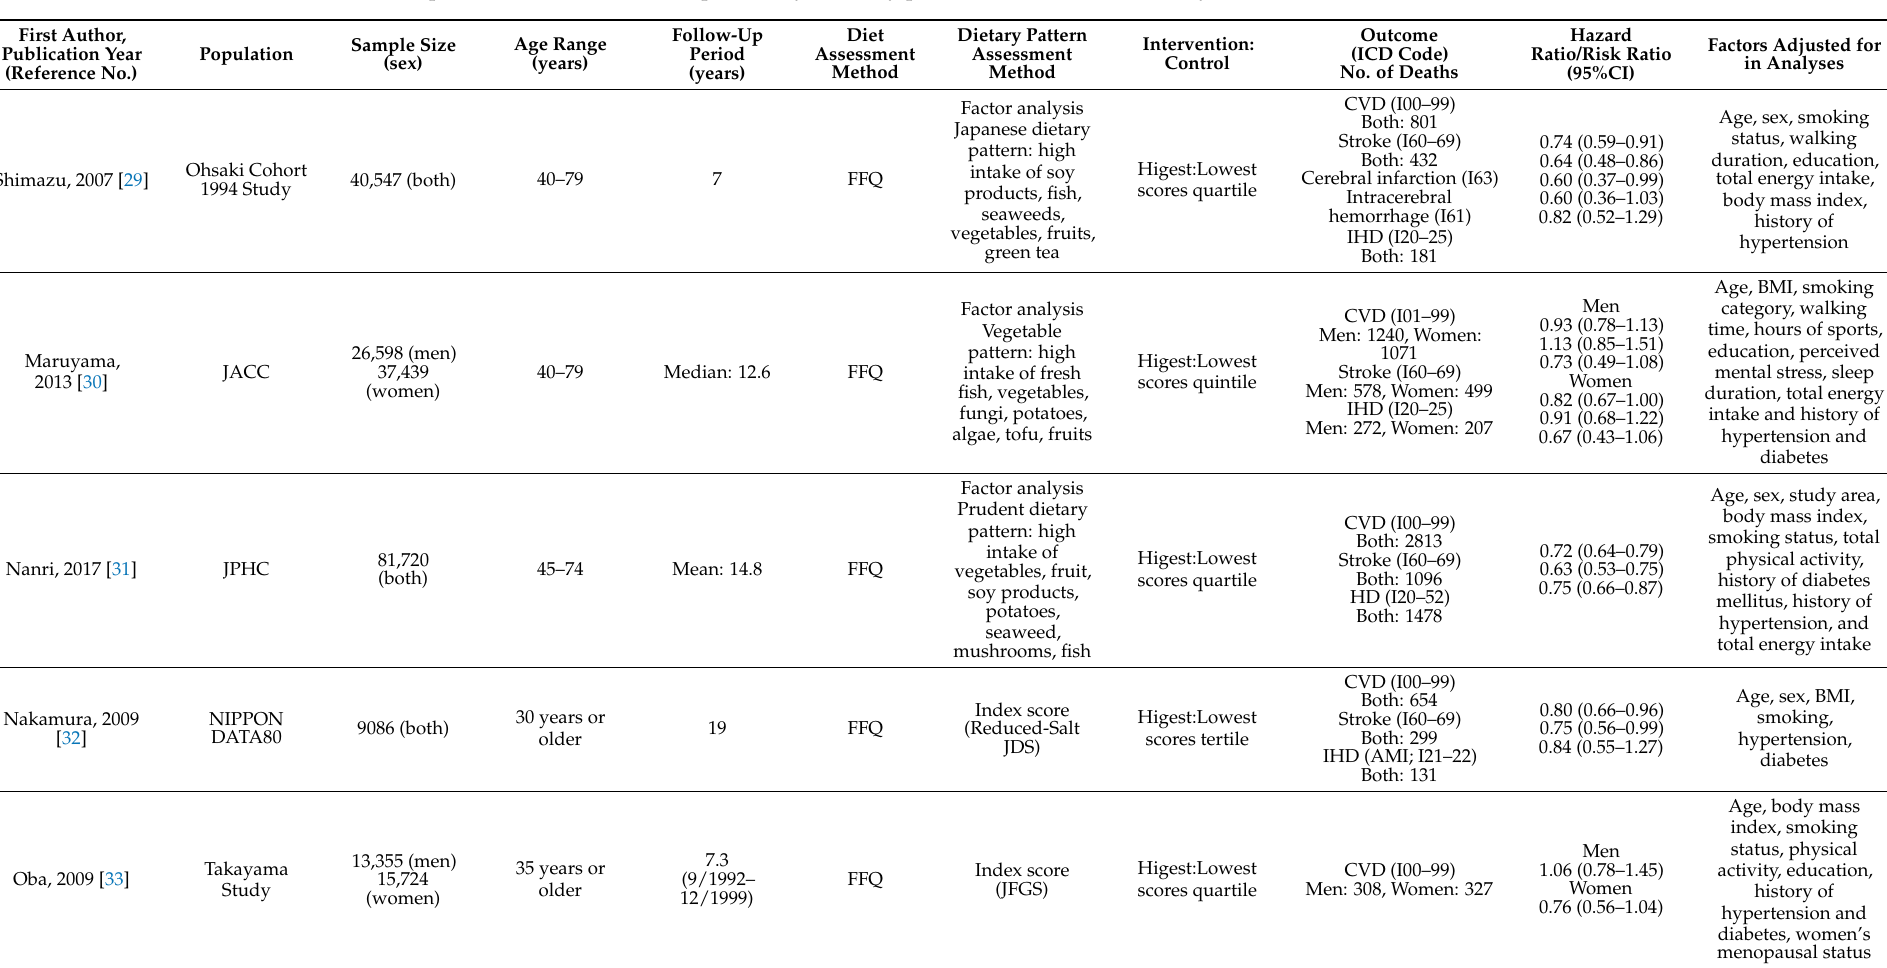
Table 1. Prospective cohort studies on Japanese-style dietary pattern and the CVD mortality risk (Hazard ratios, risk ratios, and 95% confidence